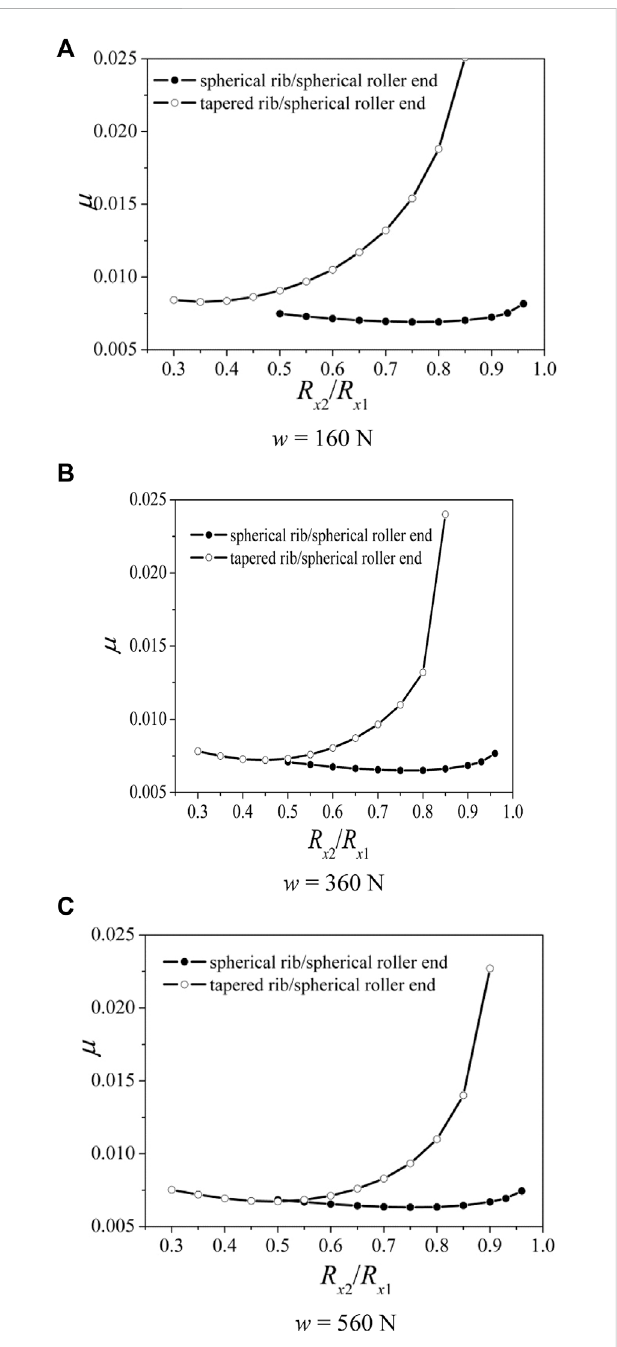
FIGURE 7 Variations in the friction coef fi cient versus R x 2 / R x 1 with different loads for n i = 1,000 r/min. (A) w = 160 N, (B) w = 360 N, and (C) w = 560